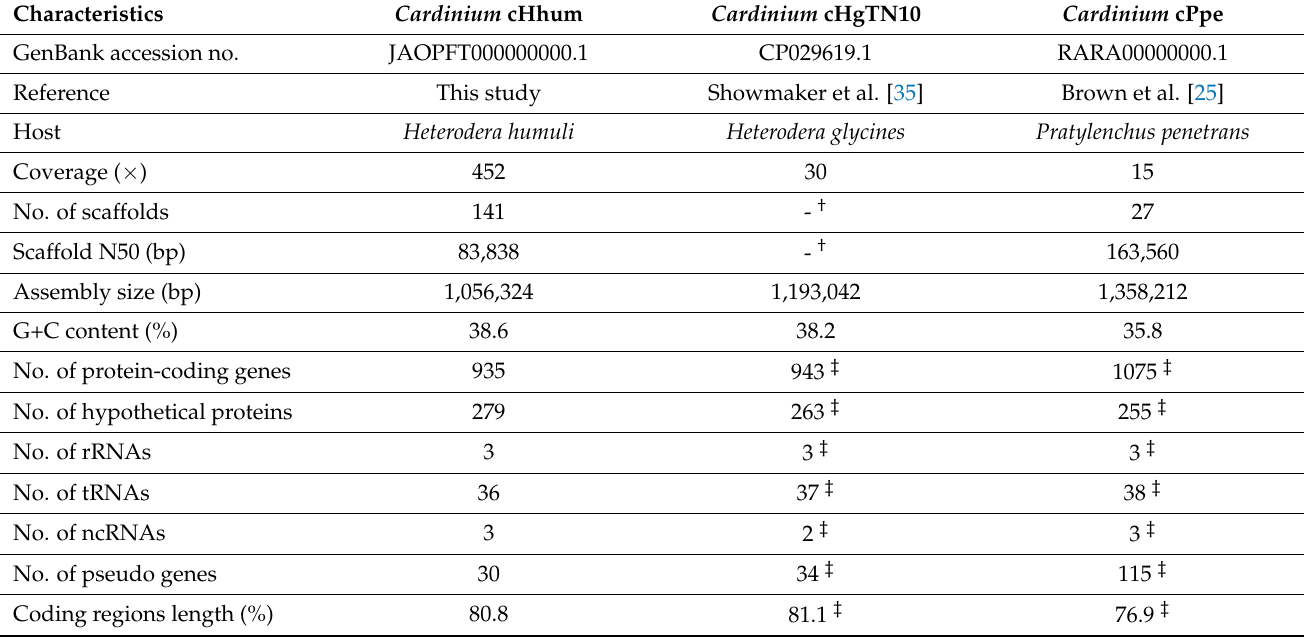
Table 2. Assembly details and genome features for strains of Cardinium clade; endosymbionts of plant-parasitic